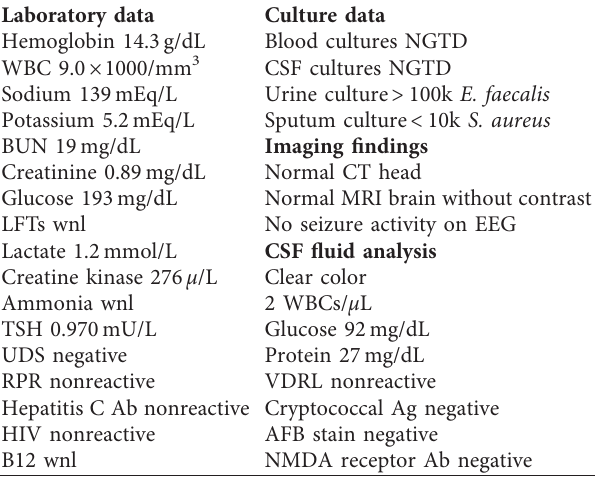
Table 1: Laboratory and radiographic